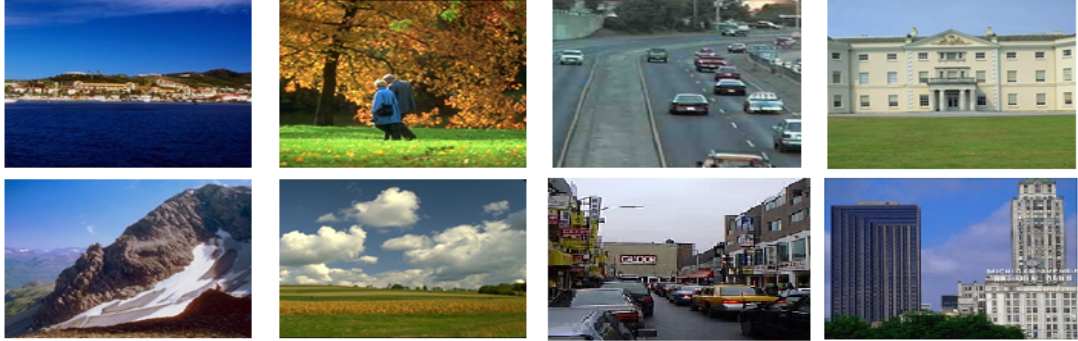
Figure 7. Class representatives from the OT image dataset